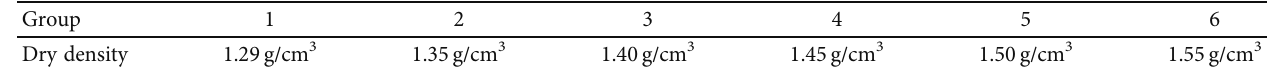
Table 1: Six groups of dry density